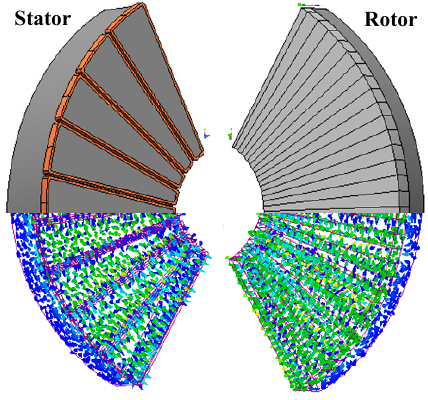
Figure 10. Axial magnetic flux arrow plot.